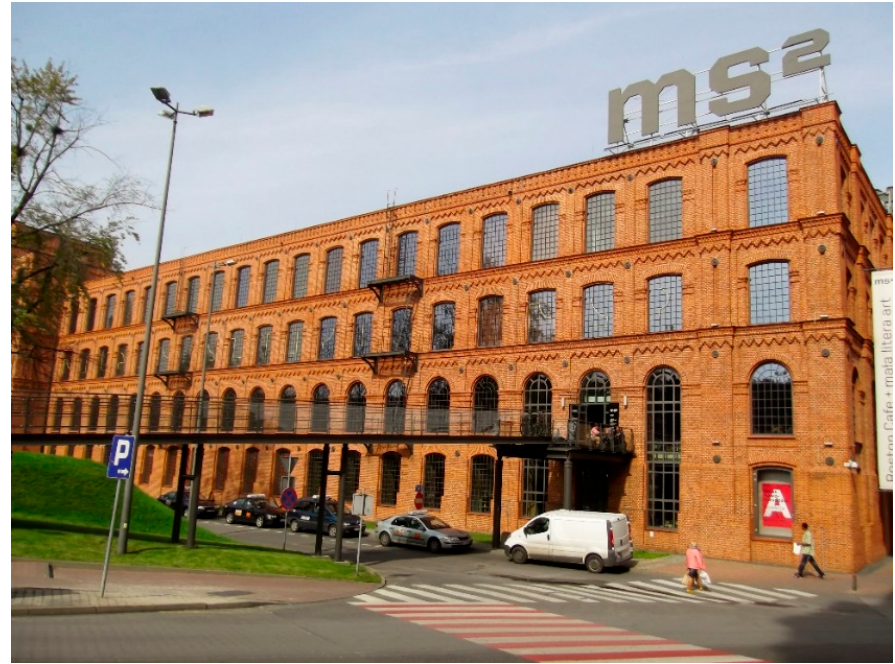
Figure 5. MS2 Art Museum in Ł ód ź , photo by Pelkian13, Wikimedia Commons, available online: https://upload.wikimedia.org/wikipedia/commons/d/d0/%C5%81%C3%B3d%C5%BA%2C_ul._Og 2021).